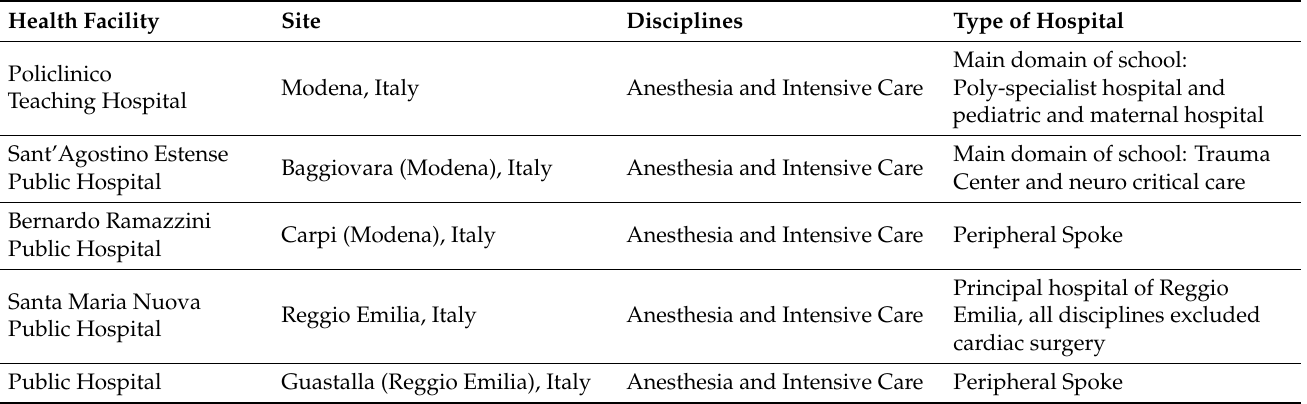
Table A1. School of Anesthesia and Intensive Care network of University of Modena and Reg- gio